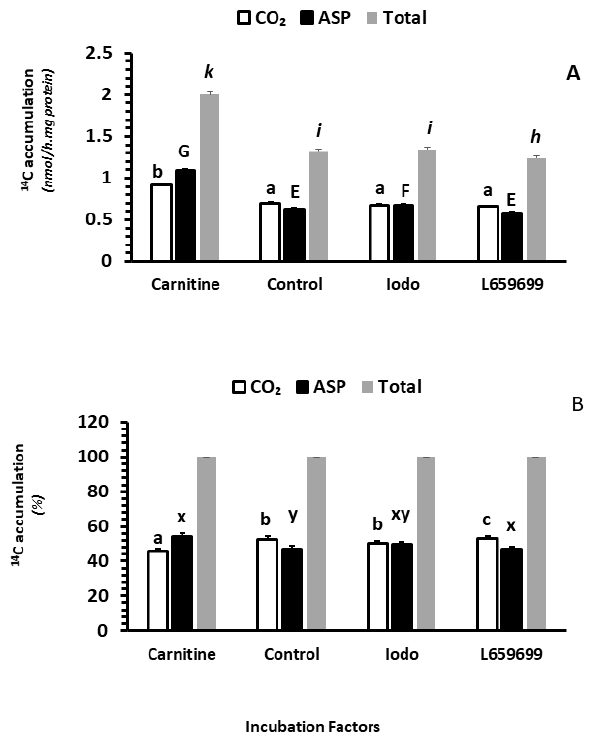
Figure 3. The effect of carnitine availability and ketogenic activity on intestinal fatty acid oxidation. ASP: acid soluble products. Data in ( A ) are 14 C accumulation in CO 2 , ASP, and Total (CO 2 + ASP). Data in ( B ) are % of CO 2 , ASP, and Total in total fatty acid oxidation. abc,GEF,kih denotes in A indicated significant ( p < 0.05) differences between groups of CO 2 , ASP and Total, and abc,xy denotes in B indicated significant ( p < 0.05) differences between groups of CO 2 and ASP % of Total. Values are least square means (n = 6) ± SEM (Standard error means). Ido, iodoacetamide (50 µM), an inhibitor of acetoacetyl-CoA deacylase (AACD), L659699, an inhibitor of H hydroxymethylglutaryl-CoA synthase (MGCS).